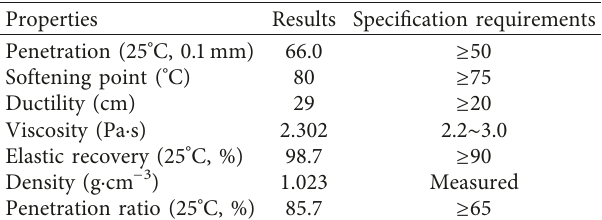
Table 1: Properties of the asphalt.